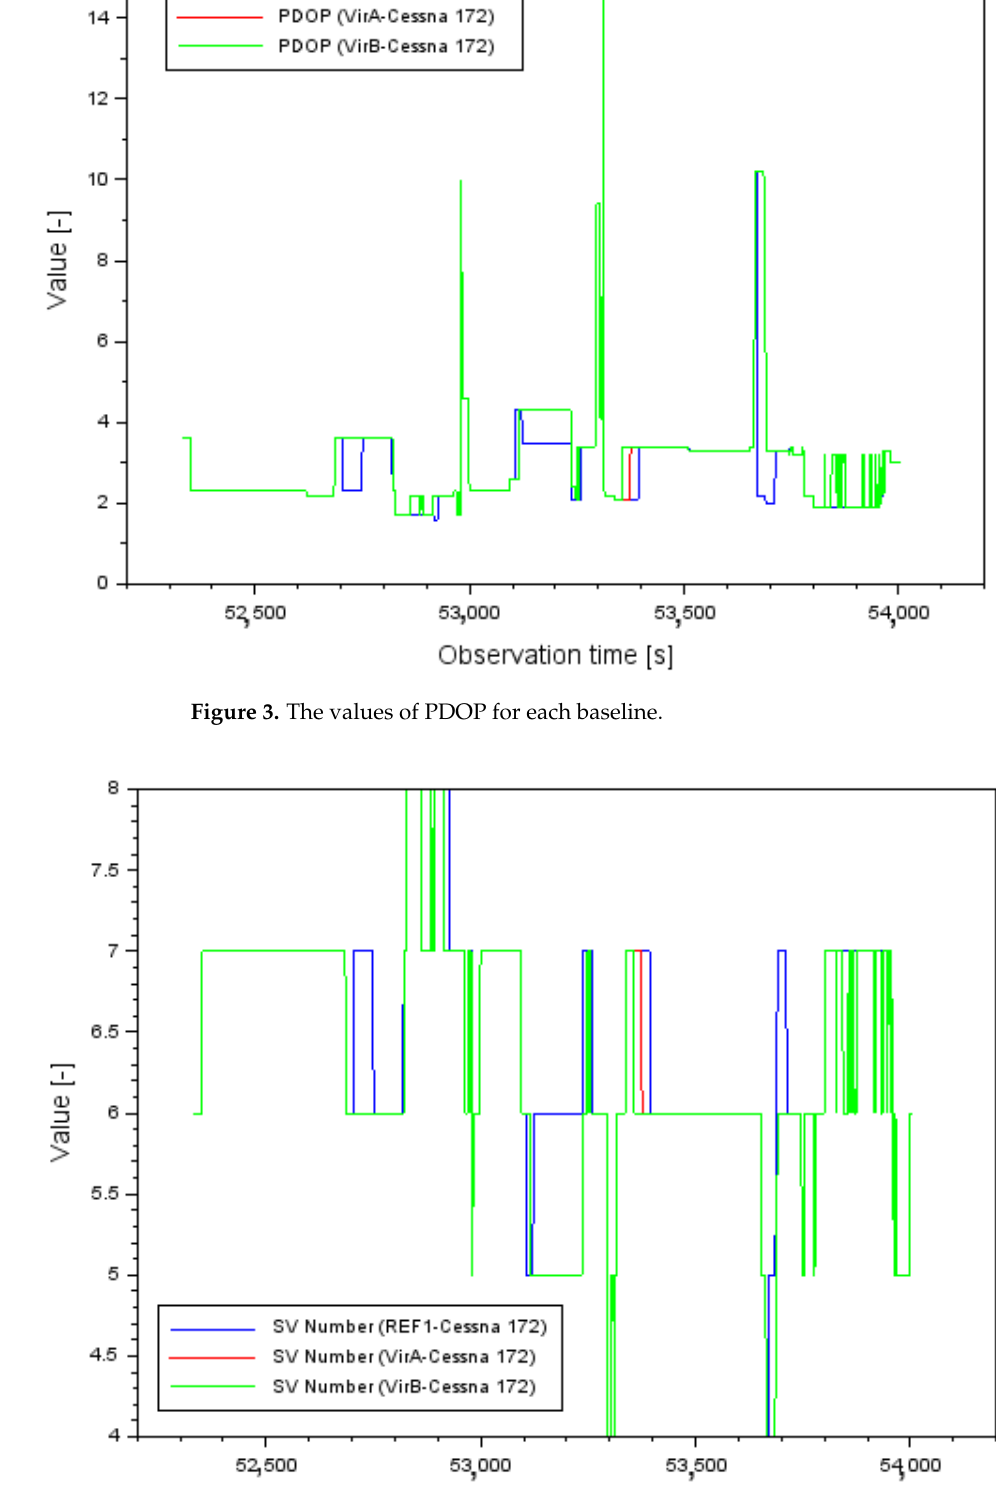
Figure 4. The SV (Satellite Vehicle) number for each baseline.